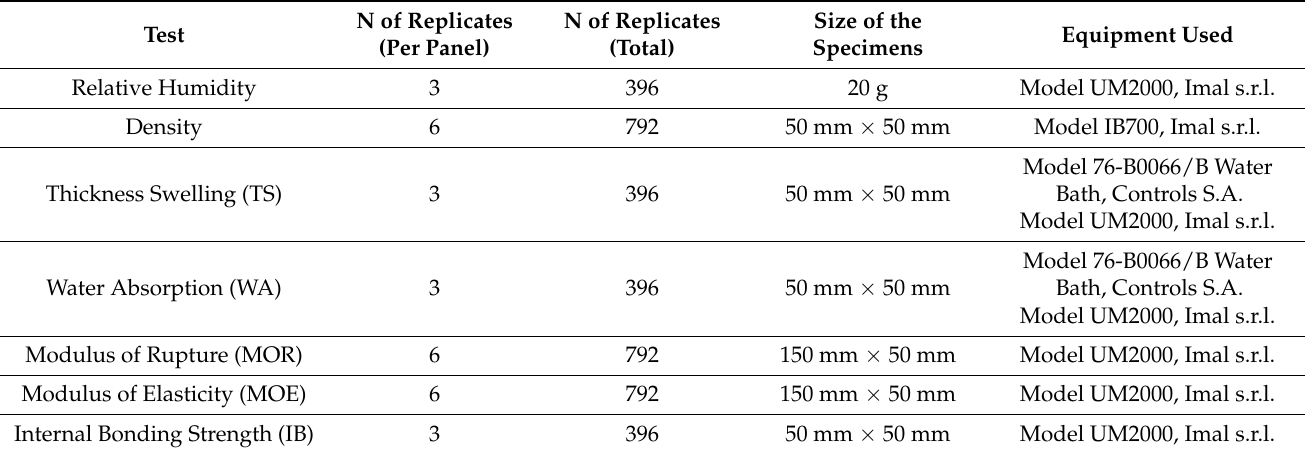
Table 3. Characteristics of the tests performed.